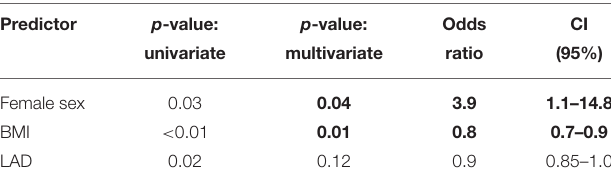
TABLE 4 | Logistic regression.